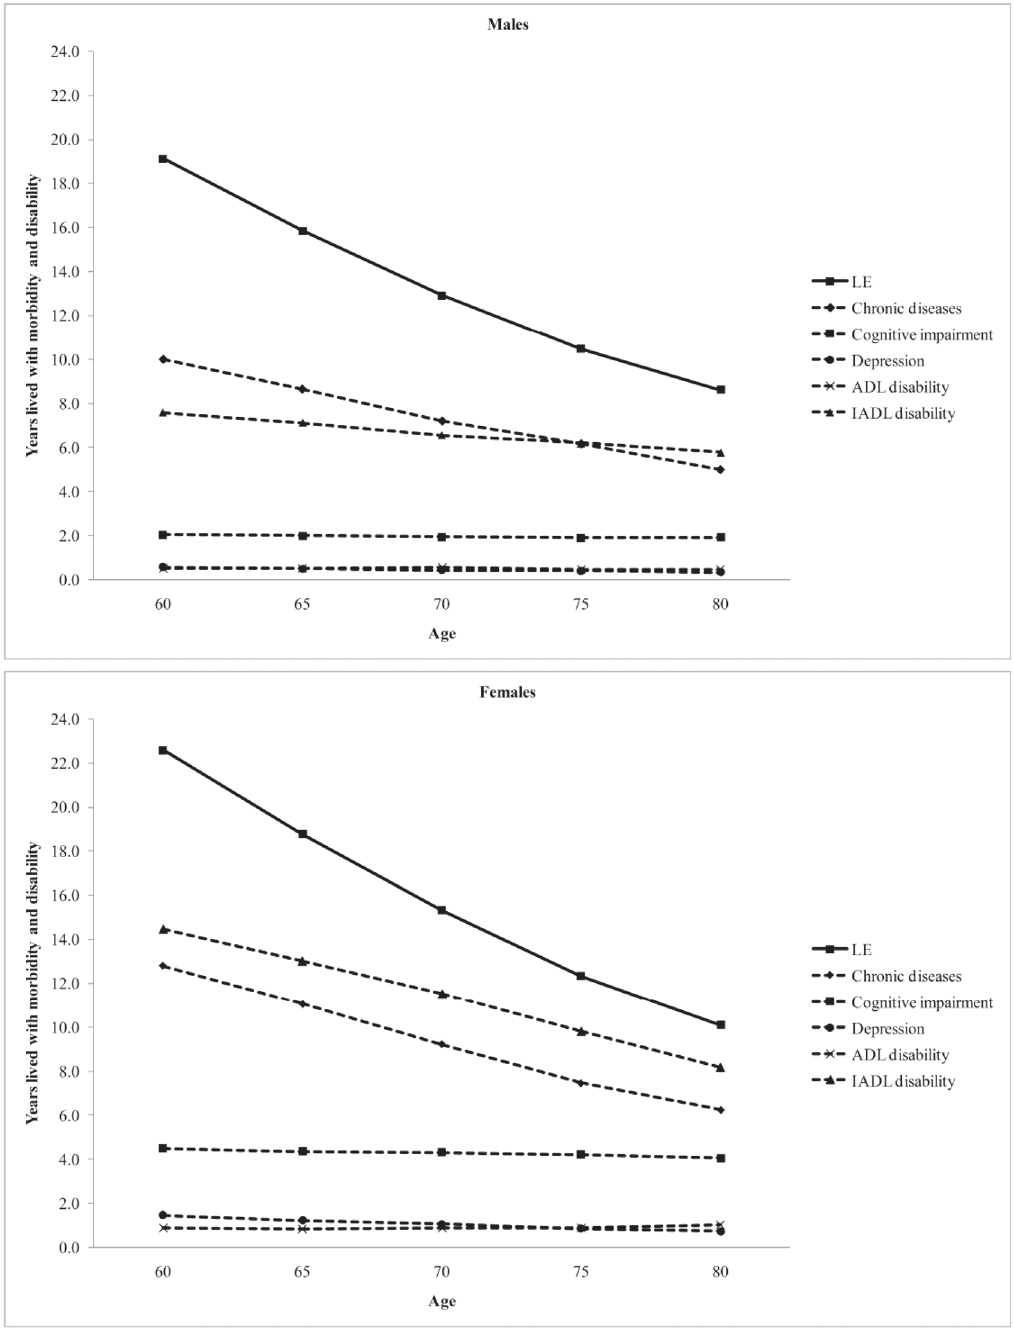
Fig 1. Total life expectancy (LE) and life expectancy spent with morbidity and disability by age and genders in Thailand, 2009.